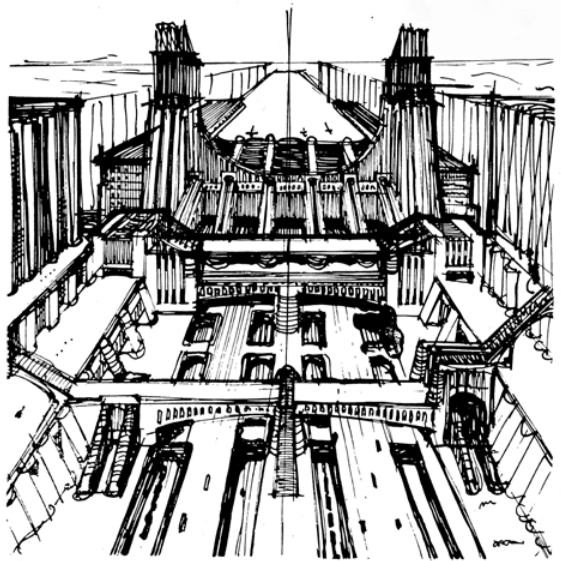
fig. 2. Cittá Nuova , antonio Sant´Elia, 1913–14 (Magnago 1983: 69). Note: It is impossible to distinguish between the lines and drawing elements that are part of the physical vehicle or the representing, and the lines or stripes that are part of the architectural object represented, such as buttresses, ribs, slits and shadows. The distinction between the representing elements and the represented elements is thus a theoretical one that only prevents us from understanding the true experience of representation.